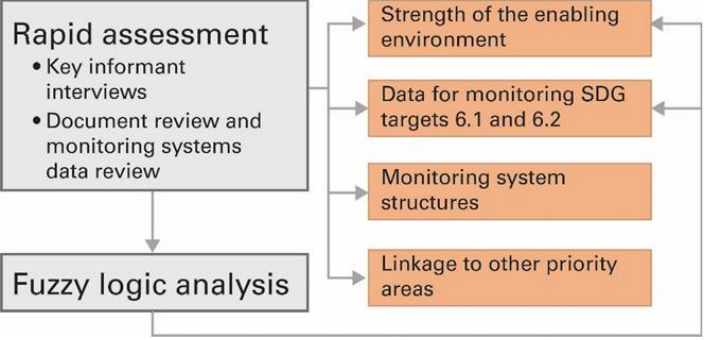
Figure 1. Methodology for study on monitoring for SDG targets 6.1 and 6.2 in ESAR.